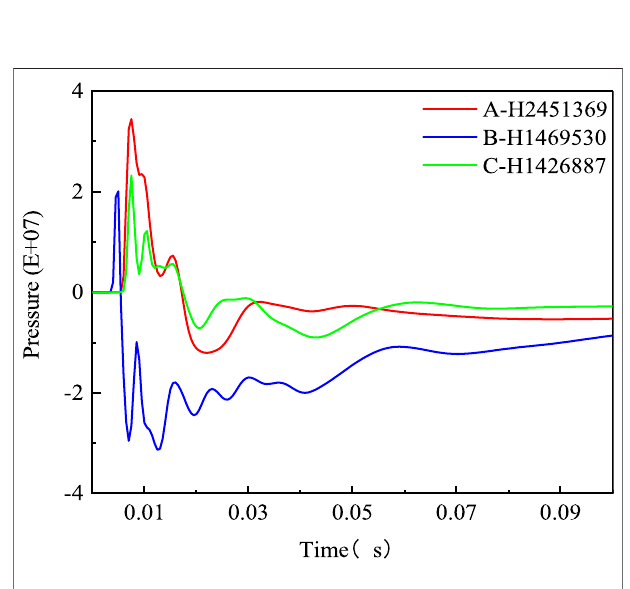
FIGURE 10 | Stress diagram at the monitoring